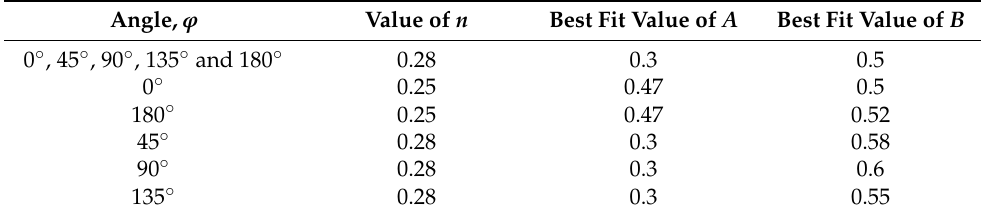
Table 3. Values of constants n , A , and B used in Equation